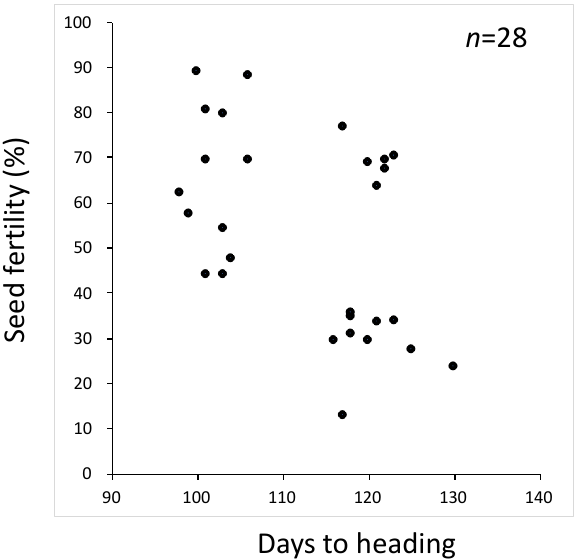
Figure 1. Scatter diagram of days to heading and seed fertility in the BC 5 F 2 population using T65 as the recurrent parent and Jpn2 as the donor parent. Table 1. Frequency distribution of seed fertility in BC 5 F 3 generation using T65 as the recurrent parent and Jpn2 as the donor parent.